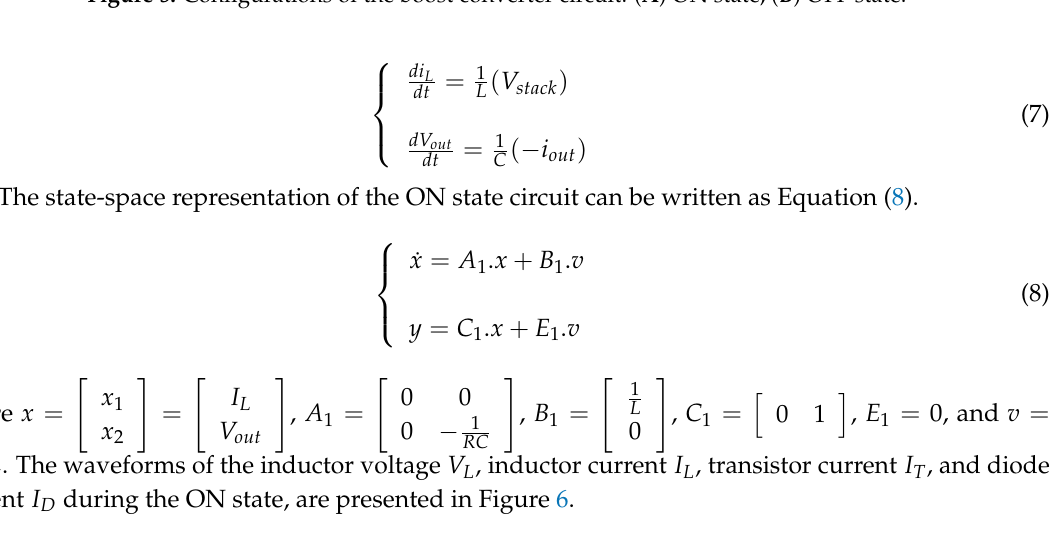
Figure 5. Configurations of the boost converter circuit: ( A ) ON state; ( B ) OFF